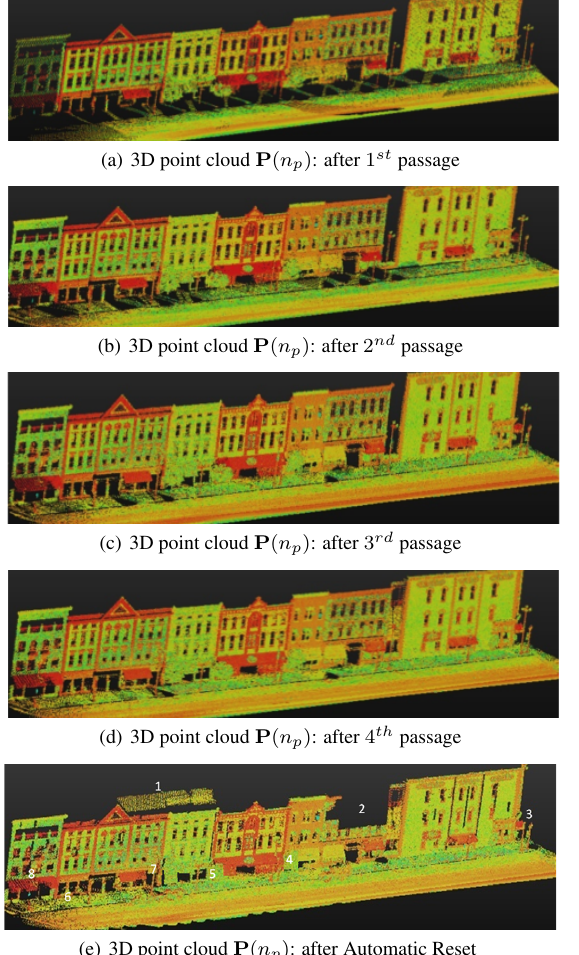
Figure 7: (a) shows the initial point cloud related to urban car- tography full of perforations. In (b), (c) & (d) completion of occluded and missing features in the urban cartography, by incre- mental updating, as changes of type-1 detected. In (e), Automatic Reset function came into action after changes of type 2 & 3 were detected to update the modifications in the 3D cartography. On (e) are also marked the changes successfully detected and updated after 4 passages. These include: 1- Building wall/ roof added due to initial misclassification; 2- Part of Building demolished; 4, 5 & 6- Trimmed or cut trees/bushes; 3, 7 & 8- Longer poles cut into half.